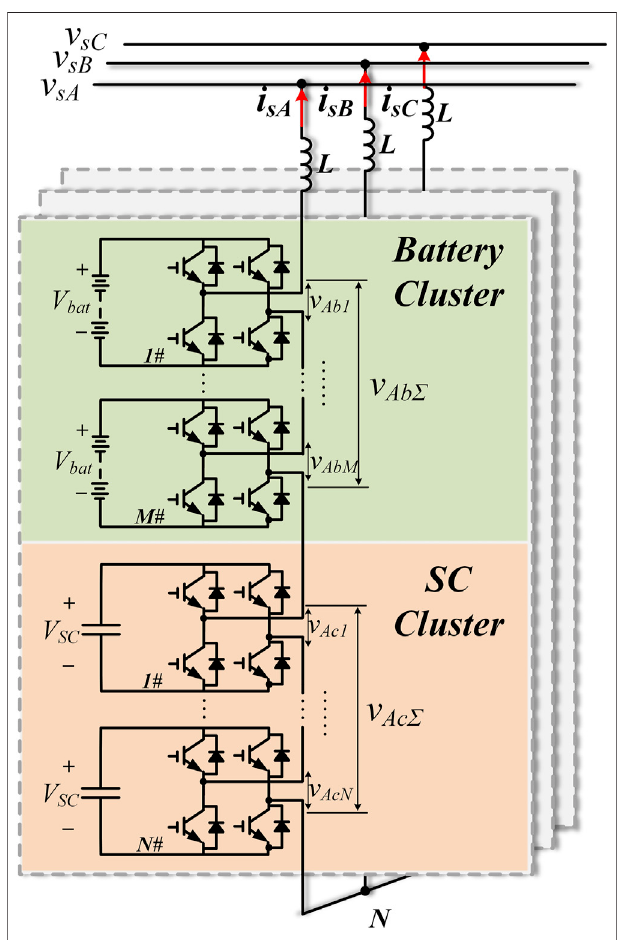
FIGURE 1 | Circuit con fi guration of star-connected battery-SC HESS using CMC.